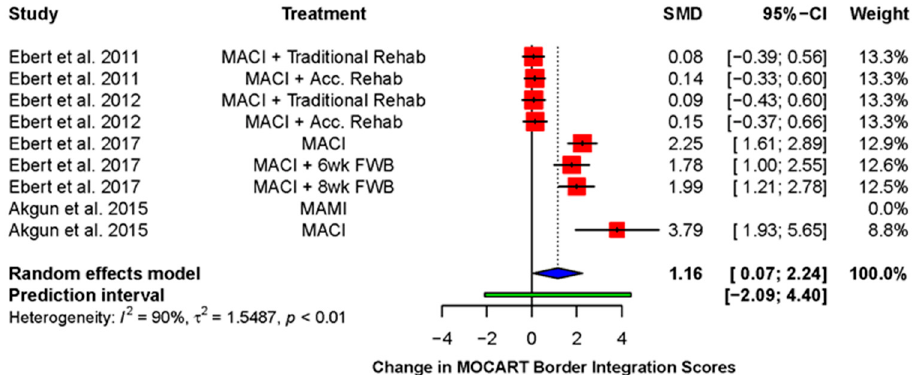
Figure 3. Forest plot on the improvement in mean integration score during follow-up after receiving therapy with a cell-seeded scaffold. (Abbreviations: MACI, Matrix-induced autologous chondrocyte implantation; MAMI, Matrix-induced autologous mesenchymal stem cell implantation; Acc., accelerated; FWB, full weight-bearing; SMD, standardized mean difference; CI, Confidence Intervals).